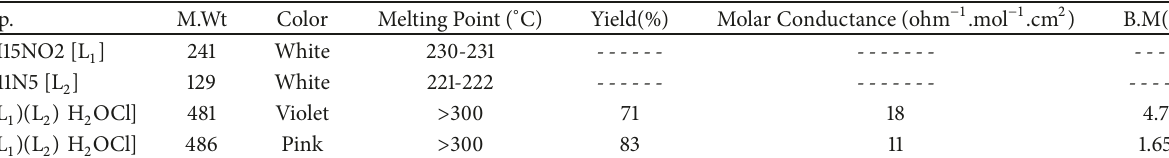
Table 1: Physicochemical properties of ligands and synthesized complexes. Comp.